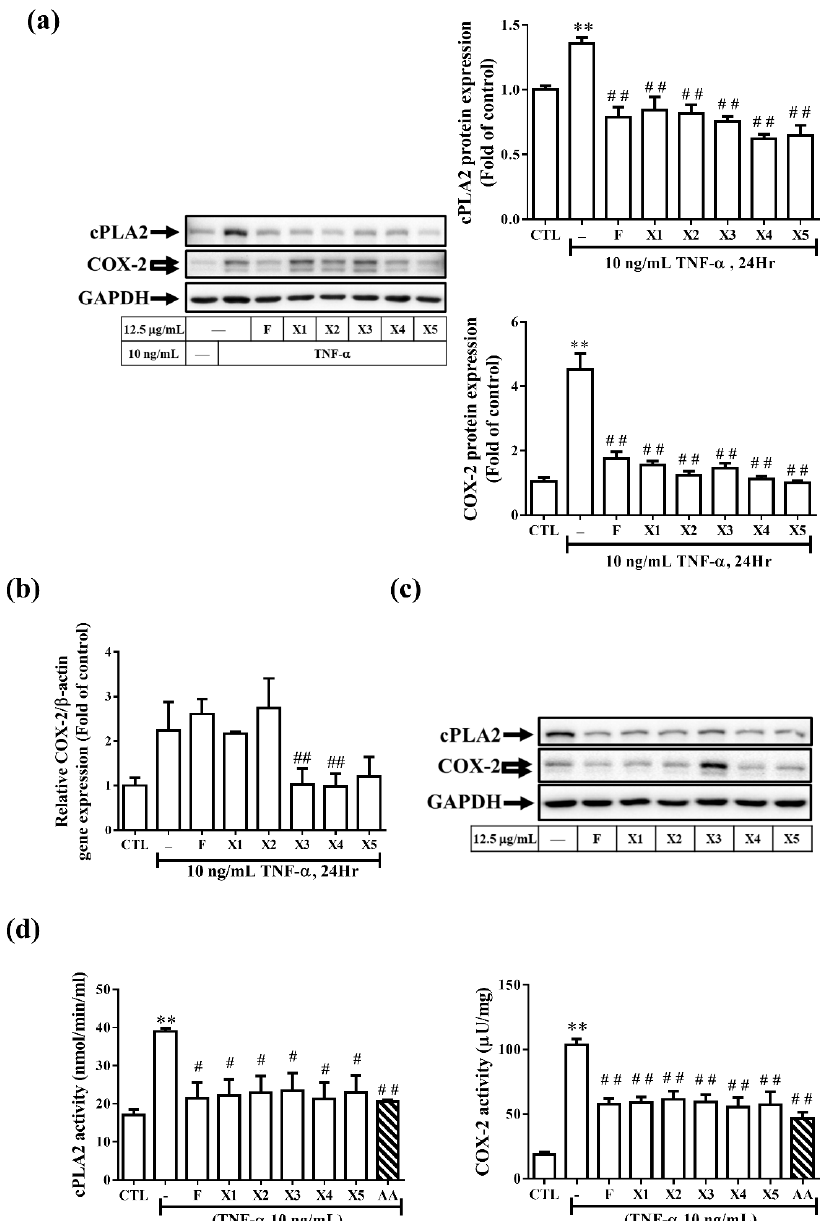
Figure 5. E ff ect of ferrocene-1 H -1,2,3-triazole hybrids on the protein expression of cPLA 2 and COX-2 in RMCs. ( a , c ) Western blot assay to detect COX-2 and cPLA 2 expression in cell lysate. ( b ) The COX-2 mRNA level was determined by real-time PCR. The sequence of addition of TNF- α reagent and compounds was as follows. In panels ( a , b ), RMCs were treated with ferrocene-1 H -1,2,3-triazole hybrids (12.5 µ g / mL) for 2 h and then exposed to TNF- α for another 24 h. In panel ( c ), RMCs were treated without or with F , X1 , X2 , X3 , X4 , or X5 at 12.5 µ g / mL for 24 h. COX-2 and cPLA 2 expression were measured by comparison with that of GAPDH (internal control). In panel ( d ), the enzyme activity assay kits to detect of endogenous cPLA 2 and COX-2 activity in RMC cell lysate (6 µ g) stimulated without or with ferrocene-1 H -1,2,3-triazole hybrids or AACOCF3 (AA) in the presence of 10 ng / mL TNF- α . Data were obtained from at least three independent experiments and are expressed as mean ± SEM.